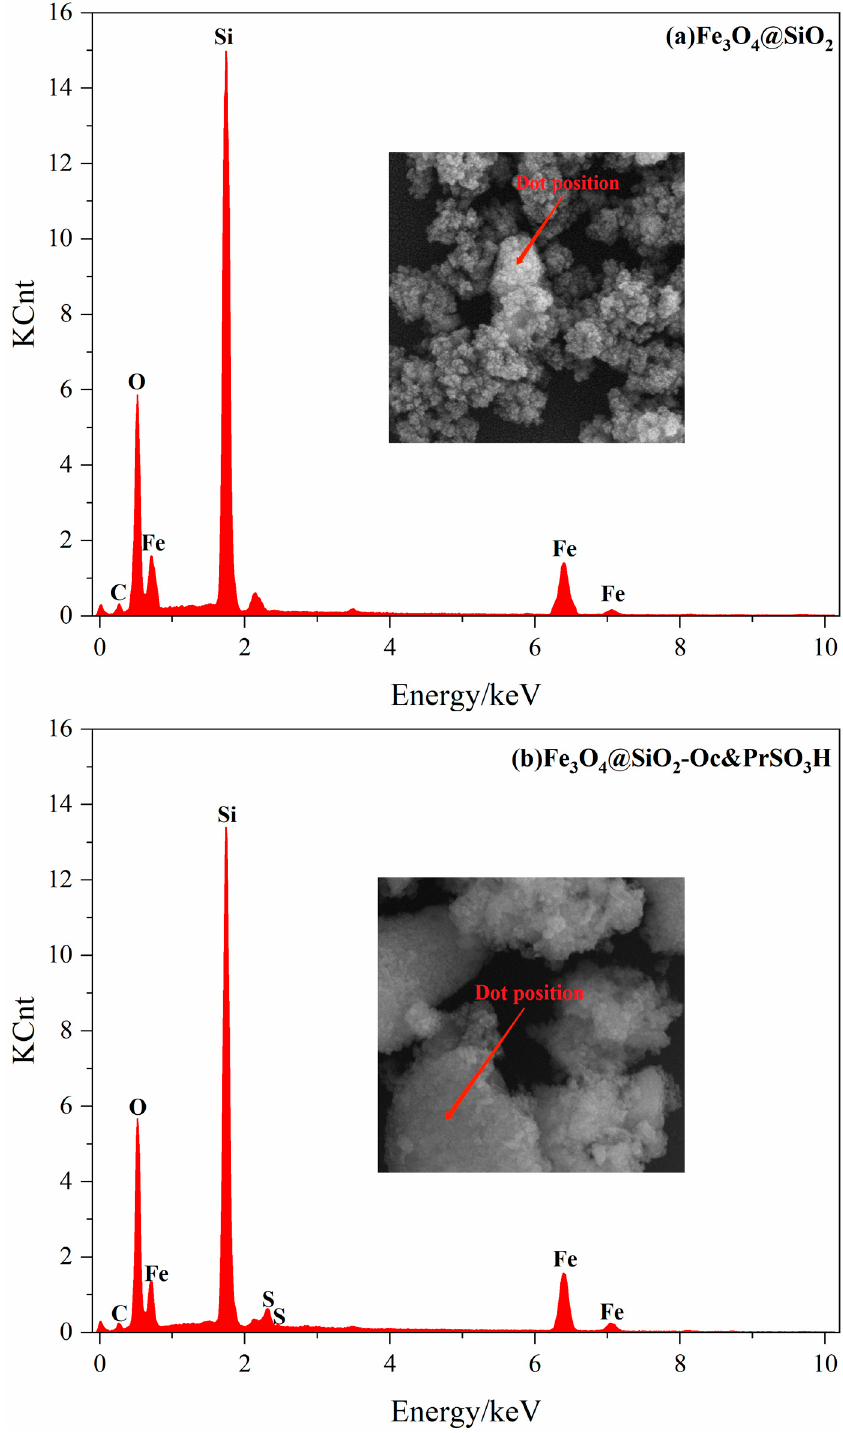
Figure 4. EDS spectra of ( a ) Fe 3 O 4 @SiO 2 and ( b ) Fe 3 O 4 @SiO 2 -Oc&PrSO 3 H; insert was dot position.